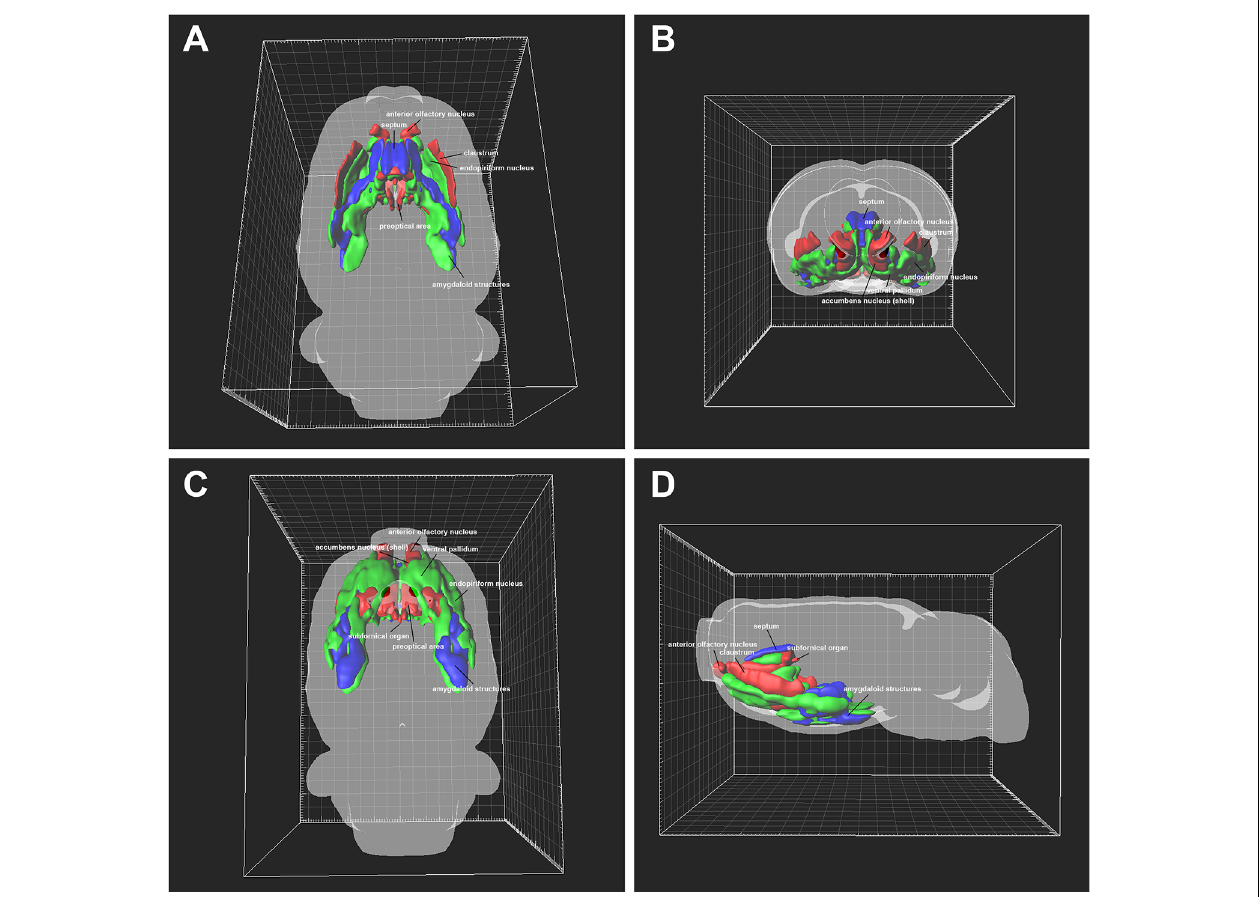
FIGURE 9 | Three-dimensional view of the projection patterns from the subcortex and limbic system to the cerebrospinal fluid (CSF)-contacting nucleus. (A) Dorsal view, (B) anterior view, (C) ventral view, and (D) lateral view. The red areas represent strong projections, the green areas represent moderate projections, and the blue areas represent weak projections to the CSF-contacting nucleus.